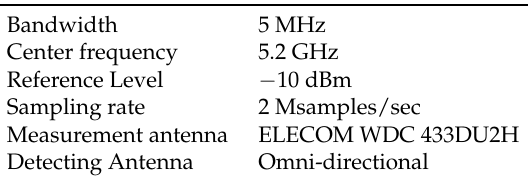
Table 2. Parameters of Signal